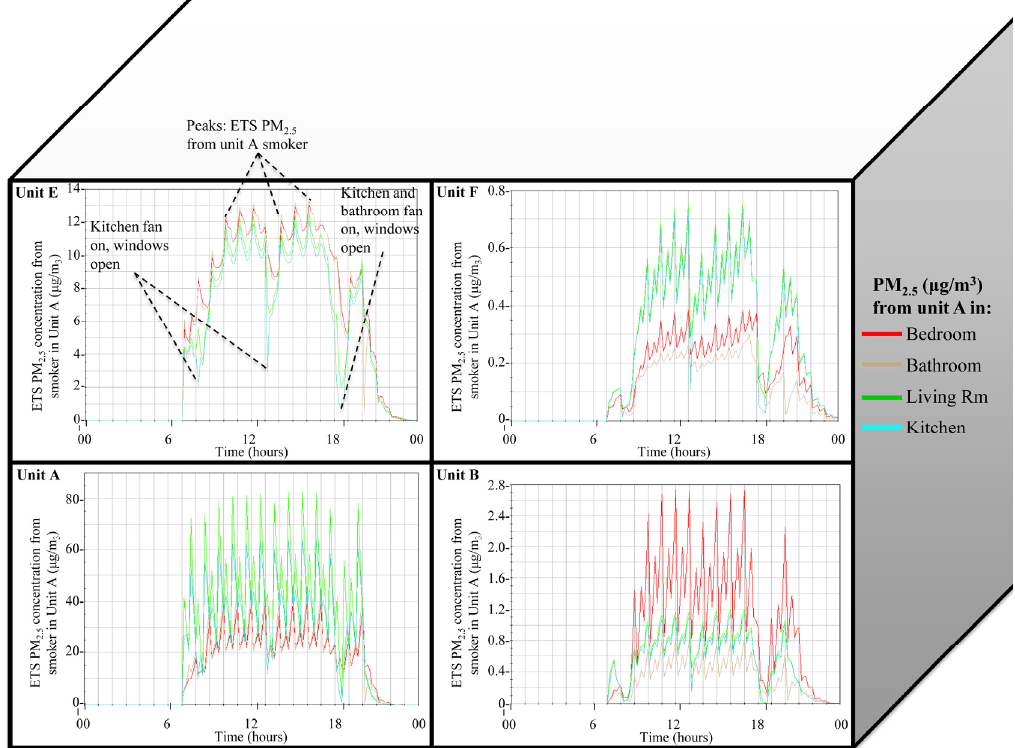
Figure 2. Predicted ETS PM 2.5 originating from the smoker in unit A measured in the bedroom, bathroom, living room and kitchen of units A, B, E, and F over a 24-h period for a post retrofit model simulated during the winter, with windows open 3 times per day in all units, and kitchen and bathroom exhaust fan used during cooking and showering activities in units A and E only. PM 2.5 concentrations in units B, E and F represent infiltration concentrations from unit A. The building is 2 townhouse units high and 4 units across, and only half the building is shown in the figure. A and E are end units, and B & F are interior units adjacent to units A and E (shown) and C and G (not shown). Note different y-axis scales.